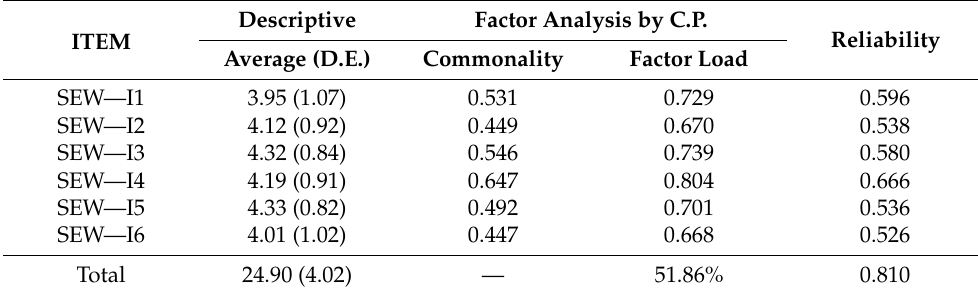
Table 4. Unidimensionality and reliability. Dimension I—Identification of family members with the company of the REI ( n = 156).